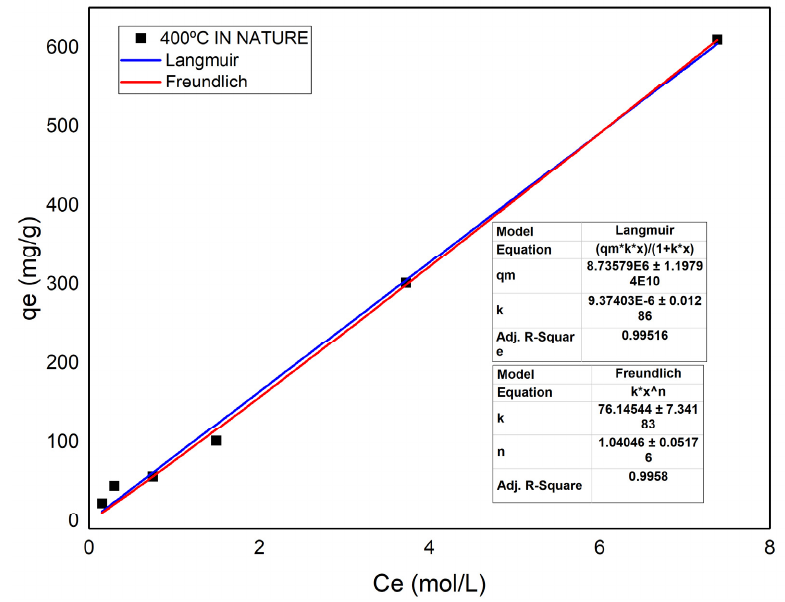
Figure 14. Langmuir and Freundlich isotherm model for adsorption experiment of in natura biochar obtained at 400 °C.